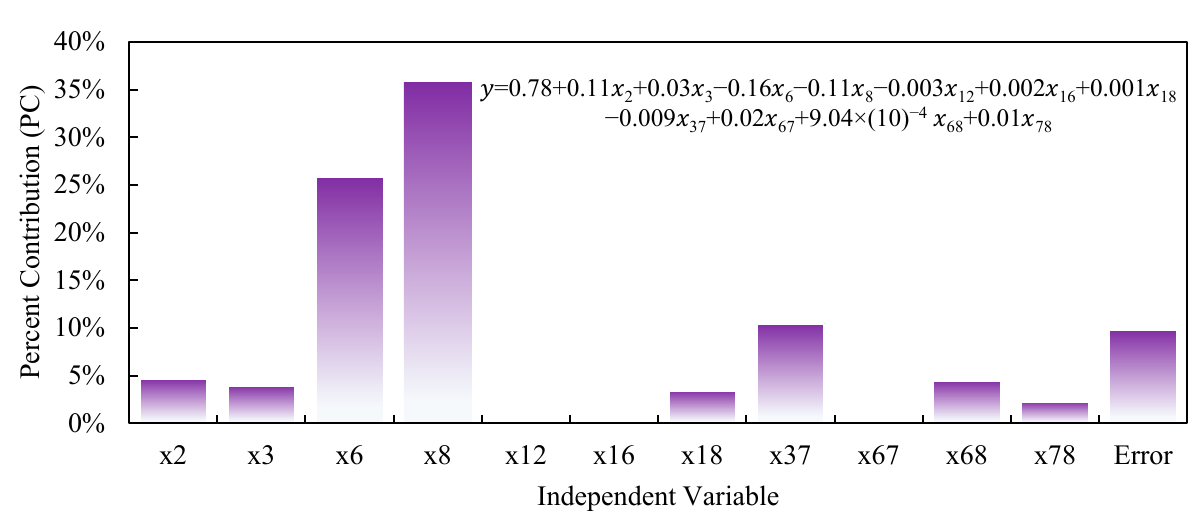
(cid:1877) =0.78+0.11 (cid:1876)